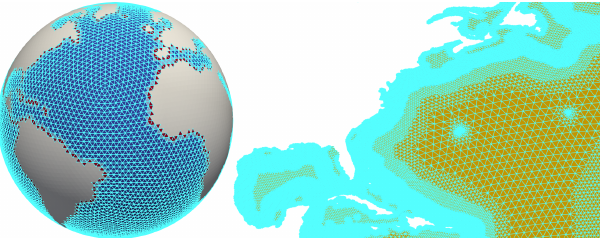
Figure 1. Left: the uniform ocean icosahedron-based grid at 160km resolution. Right: detail from the non-uniform global coastal ocean grid with resolution 8–80km used in Mathis et al.